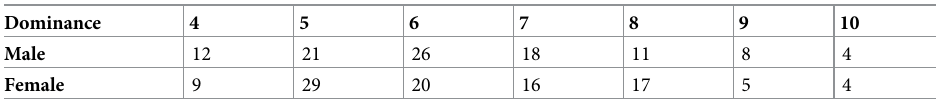
Table 4. Frequencies of number of dominant poses by sex.